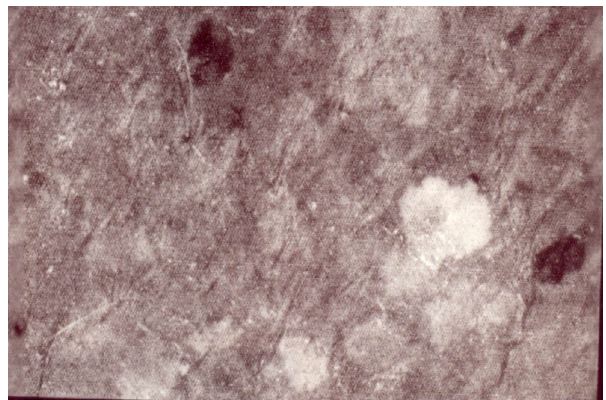
Figure 1. A woman’s leg. Single SIS in a patchwork of spotty areas of MSM of distinct darkness.